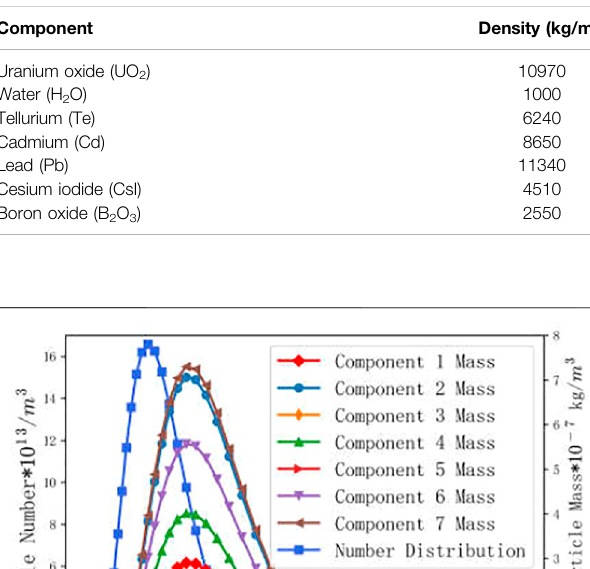
TABLE 4 | Component densities.